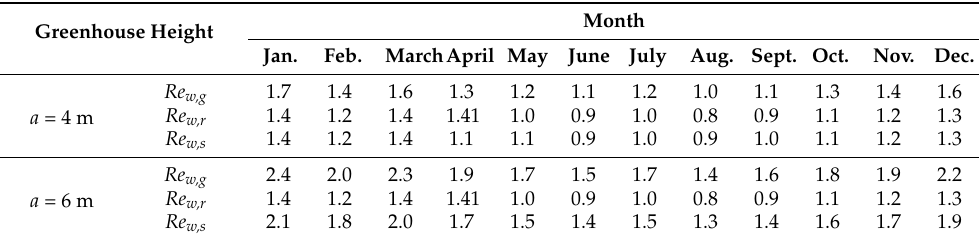
Table 3. Reynolds number values for the greenhouses under consideration and the averaged wind speeds; Re × 10 6